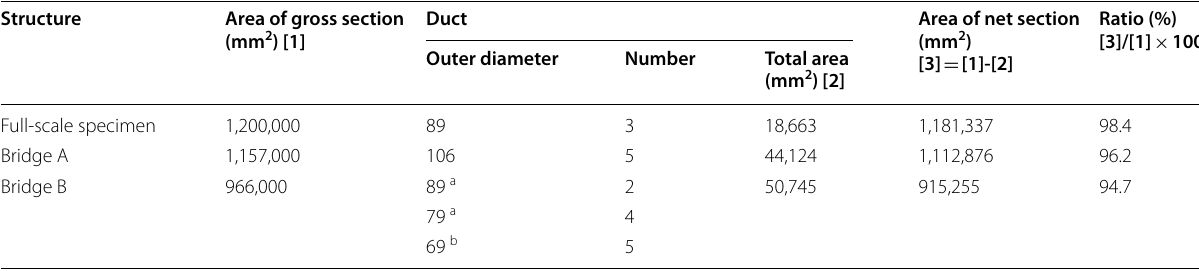
Table 5 Comparison of sectional